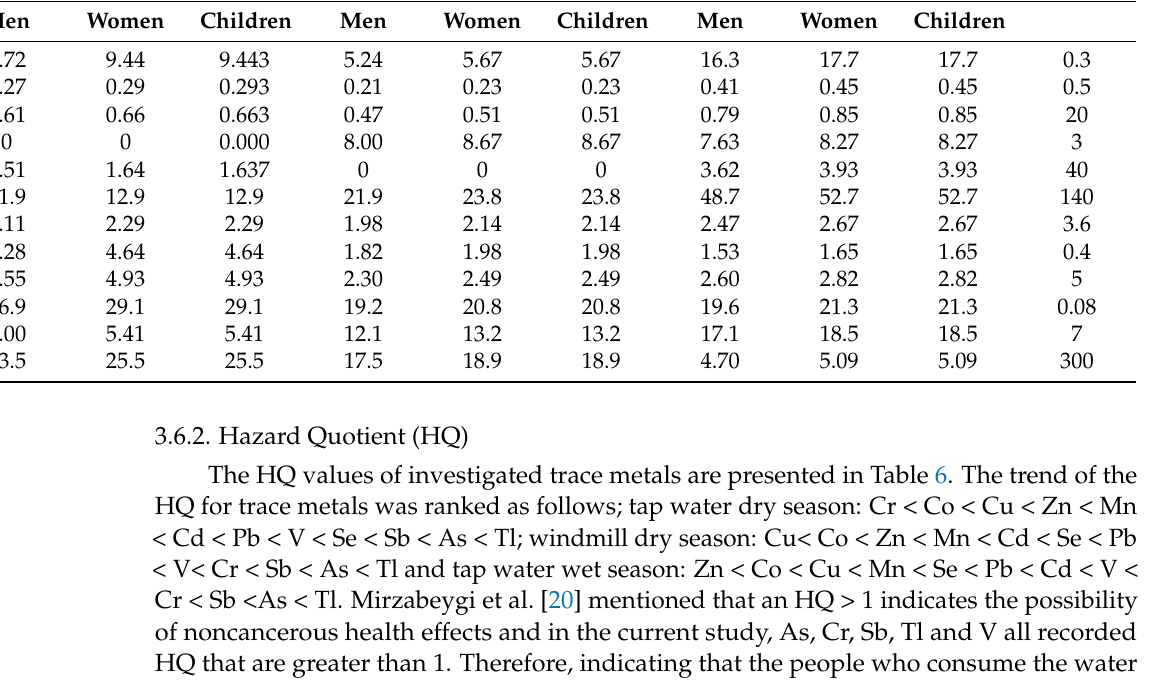
Table 5. Chronic daily intakes (CDIs, (mg/kg day)) of trace metals through drinking water. Elements Tap Water-Dry